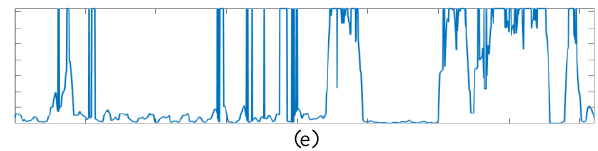
Figure 4 . Experimental results. (a) basal interface grayscale image, (b) binarization result of the grayscale image, (c) corrected echo strength corresponding to the basal interface, (d) signal thickness obtained from the binarization result, (e) variance of the signal thickness.